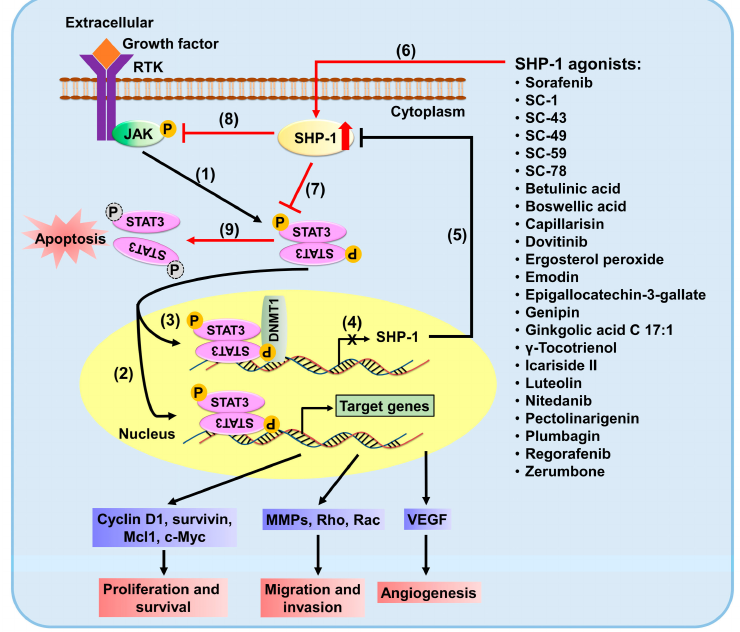
Figure 1. SH2 domain-containing protein tyrosine phosphatase 1 (SHP-1) inhibits signal transducer and activator of transcription 3 (STAT3) signaling pathways. In cancer cells, activated JAKs phosphorylates STAT3 (1), resulting in the translocation of activated STAT3 (p-STAT3) dimers to the nucleus as well as the activation of STAT3-regulated cellular proliferation and survival (cyclin D1, survivin, c-Myc and Mcl1), metastasis (MMPs, Rho and Rac) and angiogenesis (VEGFA) (2). Activated STAT3 also forms complexes with DNA methyltransferase 1 (DNMT1) at the promoter region of SHP-1 gene (3) to silence its transcription (4), leading to a decrement in protein levels (5). Enhancing SHP-1 activity by SHP-1 agonists (6) can directly dephosphorylate STAT3 (7) or its upstream JAKs (8) to decrease the p-STAT3 proteins (9) accompanied with the blockage of the STAT3-mediated cellular signaling pathways. Abbreviations: DNA methyltransferase 1 (DNMT1); Janus associated kinase (JAK); Matrix metalloproteinases (MMPs); Receptor tyrosine kinase (RTK); SHP-1 (SH2 domain-containing protein tyrosine phosphatase 1); Signal transducer and activator of transcription 3 (STAT3); Vascular endothelial growth factor